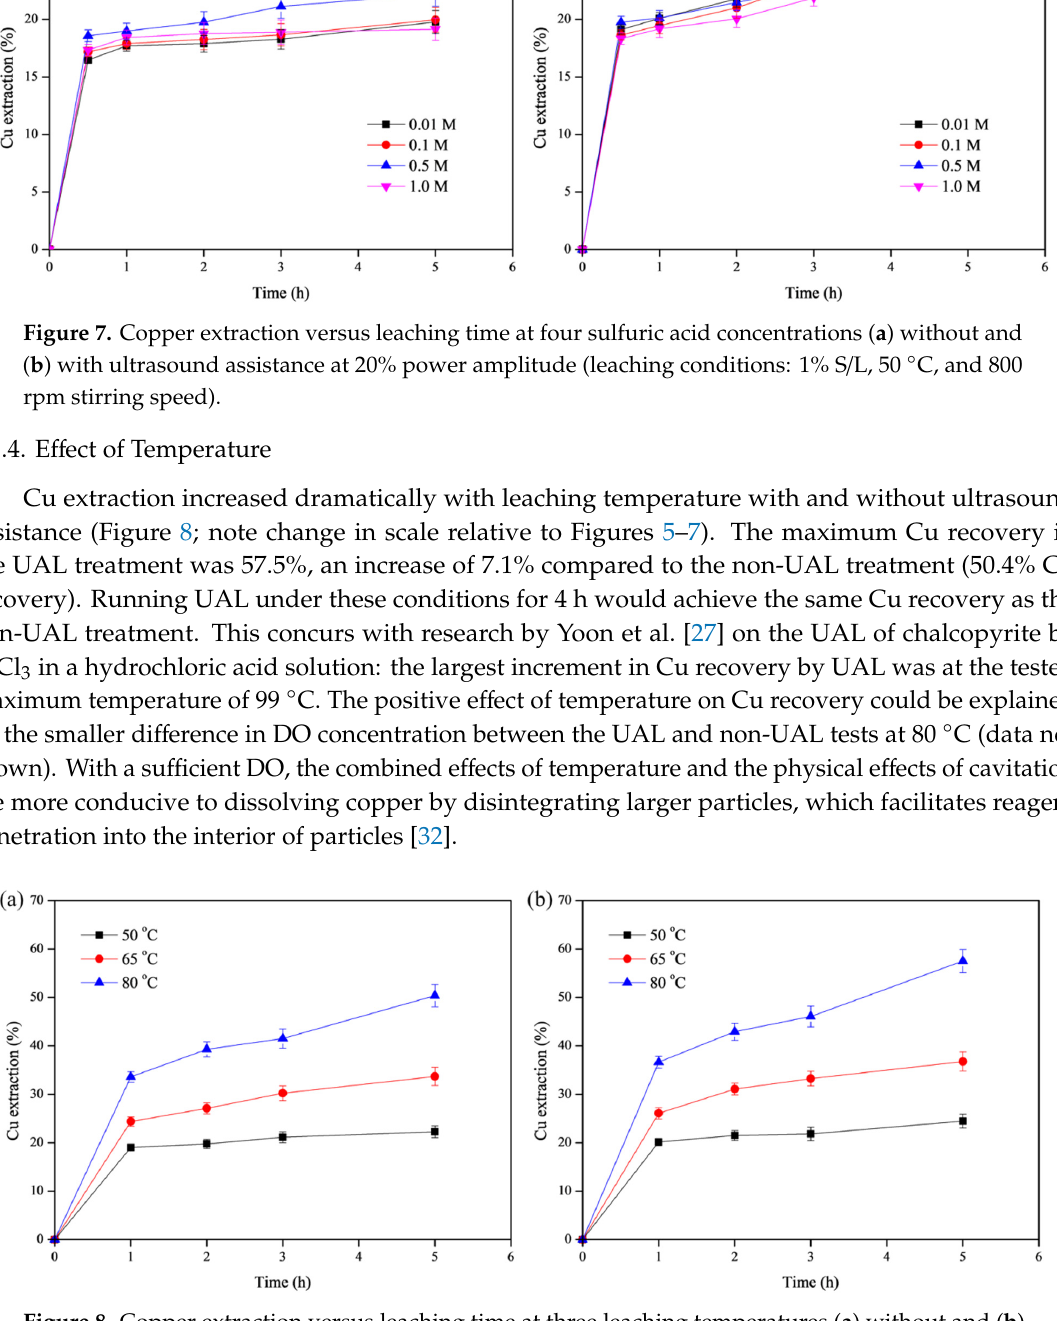
Figure 8. Copper extraction versus leaching time at three leaching temperatures ( a ) without and ( b ) with ultrasound assistance at 20% power amplitude (leaching conditions: 1% S/L, 0.5 M sulfuric acid concentration, and 800 rpm stirring speed).